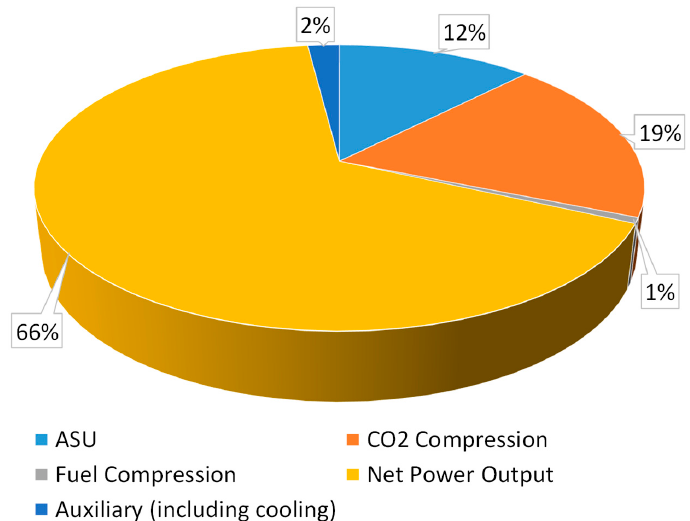
Figure 14. Distribution of the turbine power production in the natural gas-fired Allam cycle.